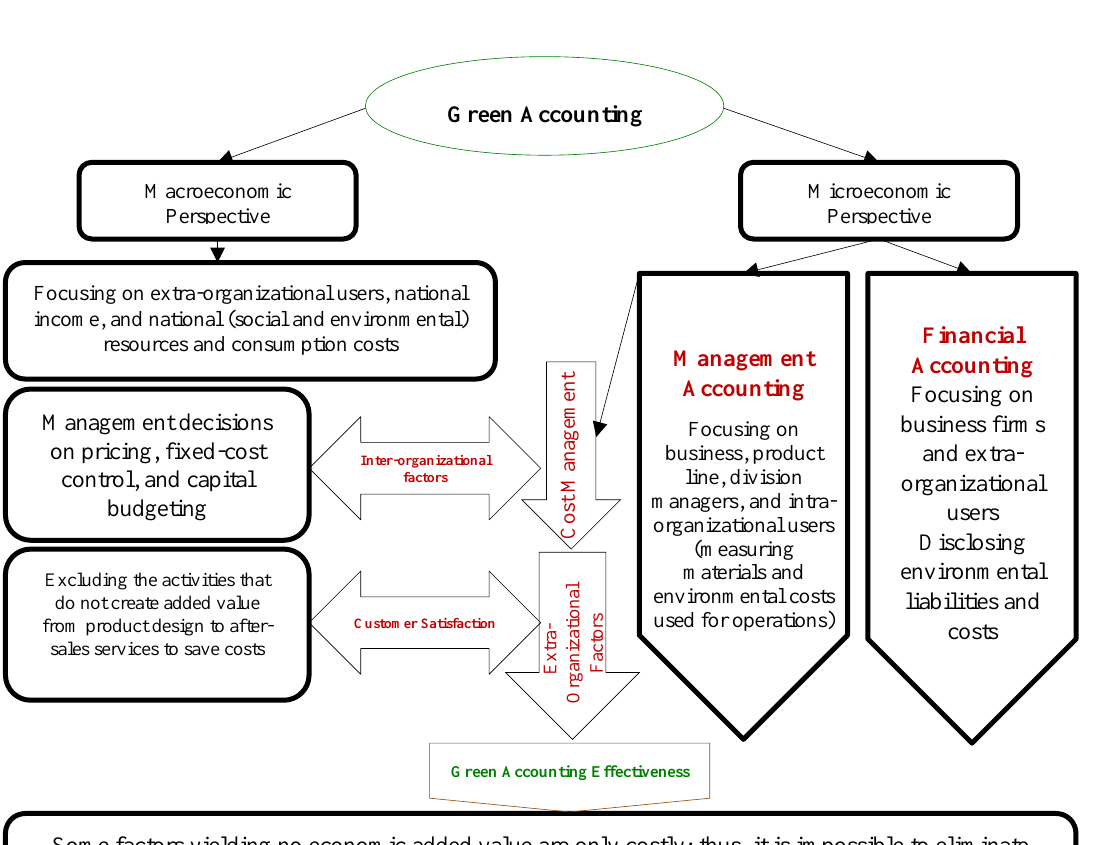
Figure 1. Strategic Applications of Green